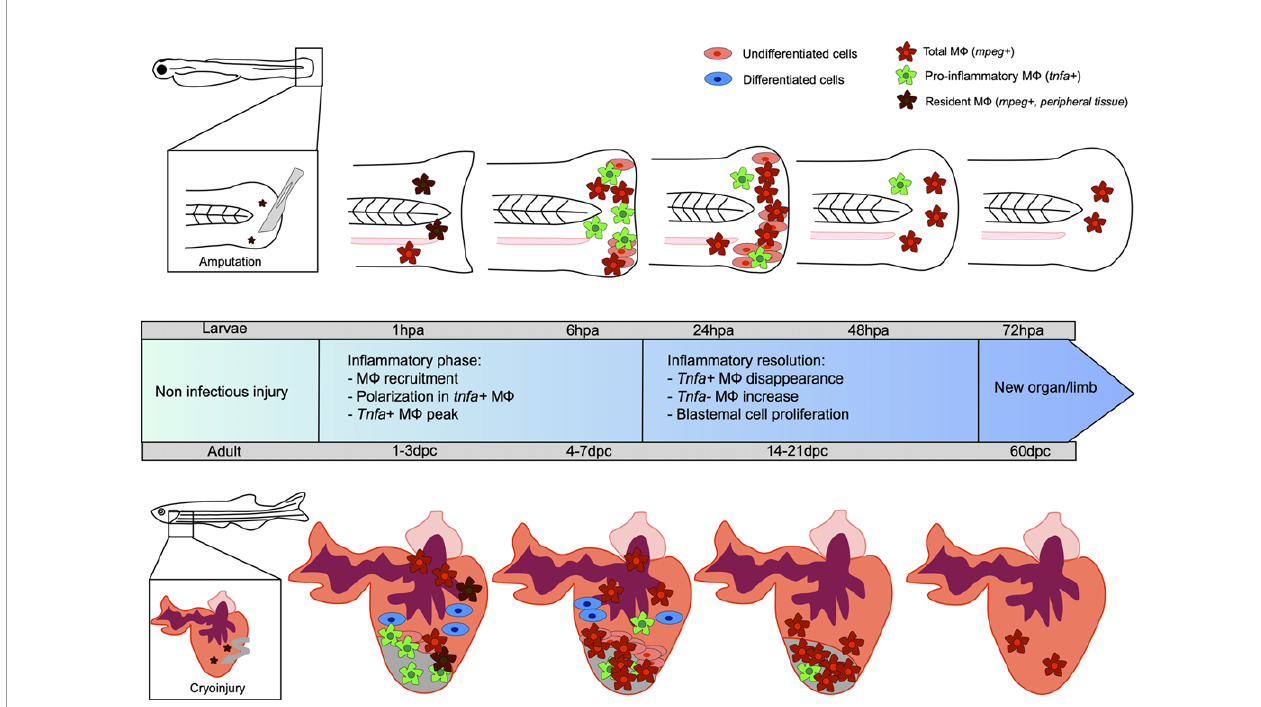
FIGURE 1 | Kinetic of caudal fi n and heart regeneration under non-infectious conditions. Transection of the zebra fi sh embryo caudal fi n in non-infected condition leads to early recruitment of M Ф , which complements the pool of resident M Ф already present in the tail. At this very early stage, resident macrophages (M Ф ) phagocytose debris and dead cells. During the in fl ammatory phase, some M Ф undergo polarization into tnfa -positive pro-in fl ammatory M Ф , reaching a peak at 6 hpa. The tnfa -positive M Ф disappear and a majority of non-in fl ammatory tnfa- negative M Ф accumulate. During resolution of the in fl ammation, the undifferentiated blastema cells proliferate, peaking at 24 hpa, resulting in new limb formation. Cryoinjury of the heart of the adult zebra fi sh leads to an early recruitment of M Ф , completing the pool of resident M Ф already present in the heart, between 1 and 3 dpc. Tnfa-positive pro-in fl ammatory M Ф predominantly arrive at the site and the proliferation of undifferentiated cells around the wound constituting the blastema begins. Already differentiated cardiomyocyte cells participate in tissue restoration. Non-in fl ammatory M Ф represent the major cells present until the end of the regeneration process, resulting in a healed